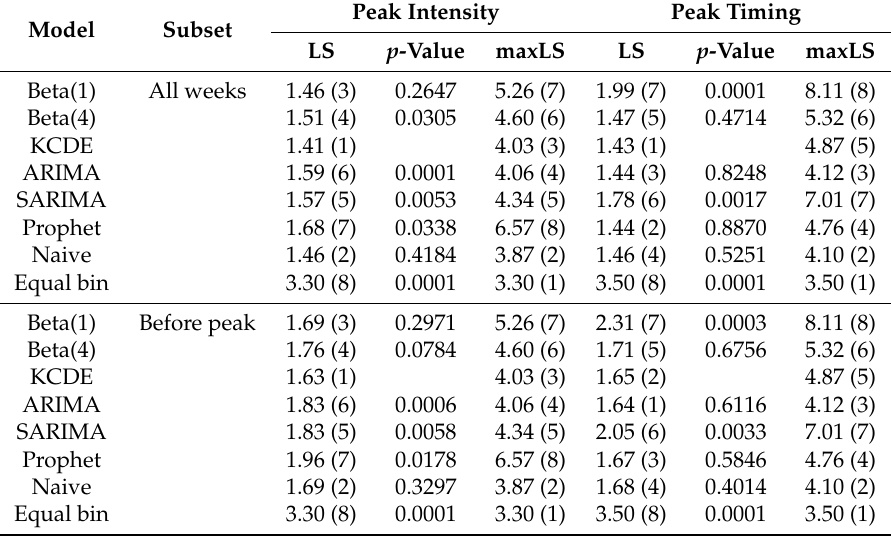
Table 3. Summaries of model performances for predictions of peak intensity and peak timing. The “all weeks” group shows the average log scores (LS) and maximum log scores (maxLS) over all predictions in the test period (n = 124). The “before peak” group summarizes the log scores for predictions in weeks before the actual peak of the given season (n = 63). The Monte Carlo p -values for differences in mean log scores are based on 9999 random permutations, comparing each model against KCDE.